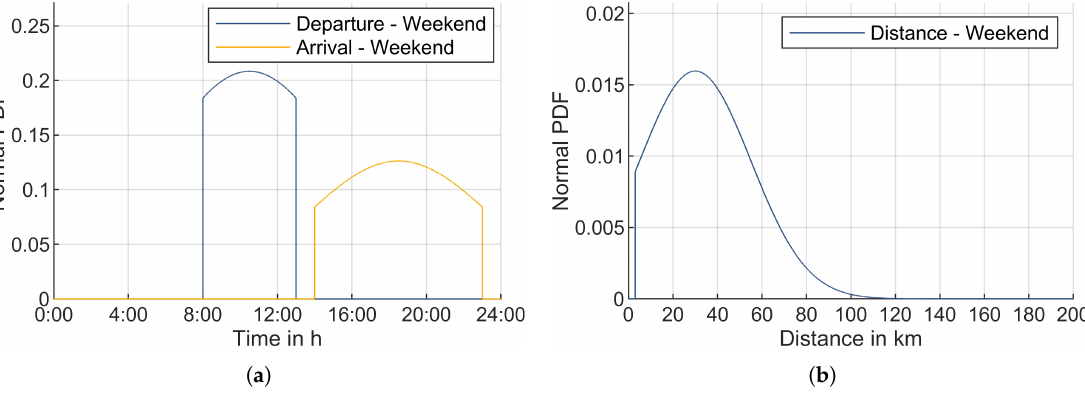
Figure 6. Probability density functions (PDFs) of the driving profiles for all mobility profiles on the weekend. ( a ) PDF of the normal distribution used to model the departure and arrival times at home on the weekend (Saturday and Sunday) for all mobility profiles; ( b ) PDF of the normal distribution used to model the driving distance on the weekend (Saturday and Sunday) for all mobility